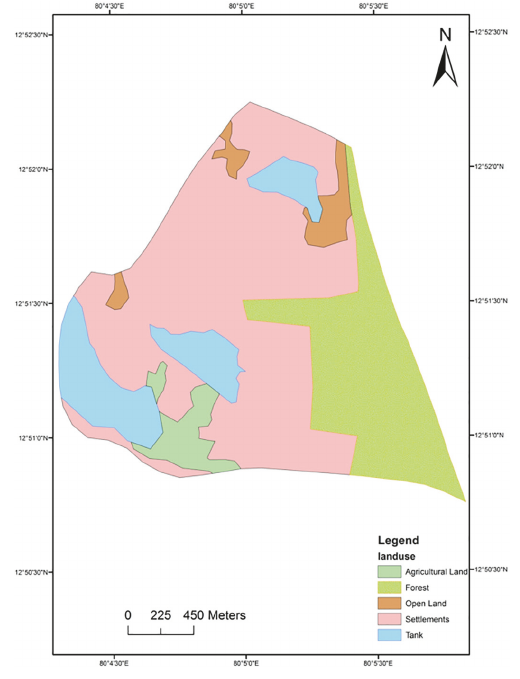
Figure 2: Land use map of Urapakkam watershed.